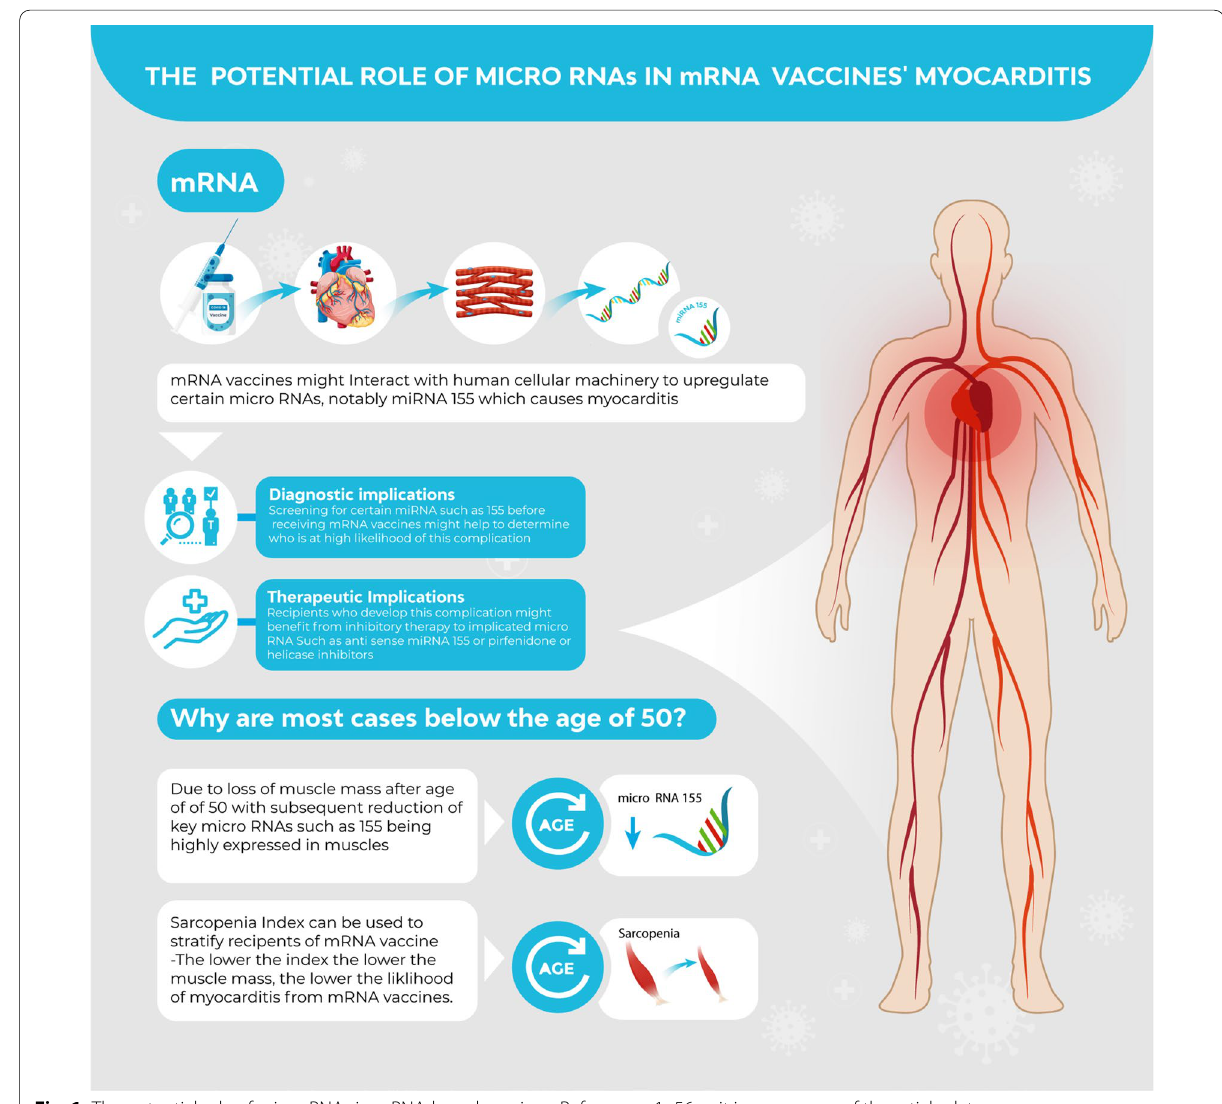
Fig. 1 The potential role of micro‑RNAs in mRNA‑based vaccines. References: 1 – 56 as it is a summary of the article